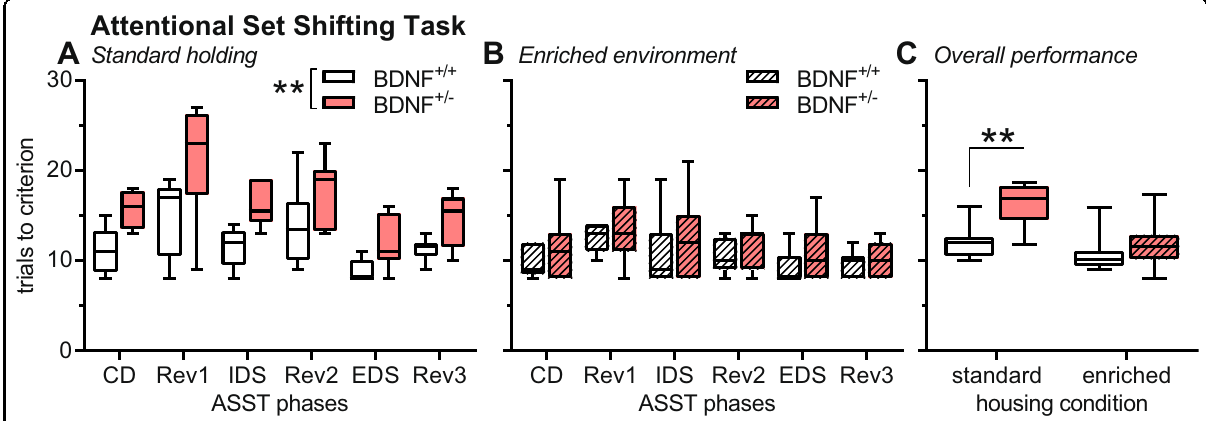
Fig. 2 EE housing prevents the ASST performance de fi cits of BDNF + / − mice. A – C Number of trials necessary to reach the criterion of six consecutive correct trials in the ASST, either depicted for the single phases of the task ( A , B ) or for the overall performance, i.e., the mean of all phases ( C ). (A) In all phases of the task, the number of trials to criterion was increased in BDNF + / − mice after standard housing demonstrating an overall impairment. B After enriched environment, this difference between the genotype was not observed, indicating that the enriched environment rescues the performance de fi cits in BDNF + / − mice ( C ). Group sizes: standard housing: 10 BDNF + / + mice, 8 BDNF + / − mice; enriched environment: 9 BDNF + / + mice, 11 BDNF + / − mice. ** P < 0.01, main effects in ANOVA ( A ) or post hoc comparisons as indicated ( C ). CD compound discrimination, EDS intradimensional shift, IDS intradimensional shift, Rev